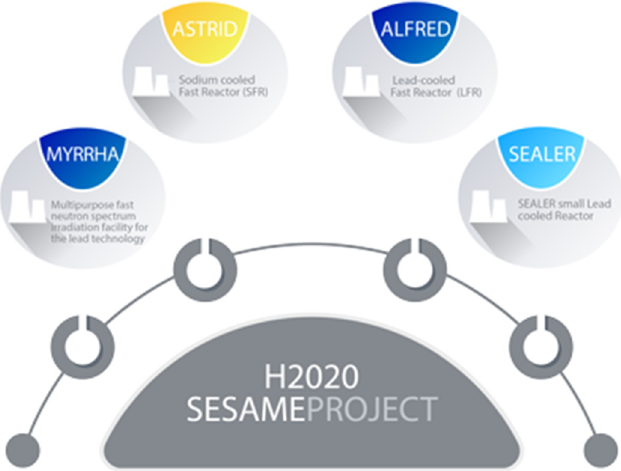
Fig. 1. European liquid metal cooled reactor demonstration projects.